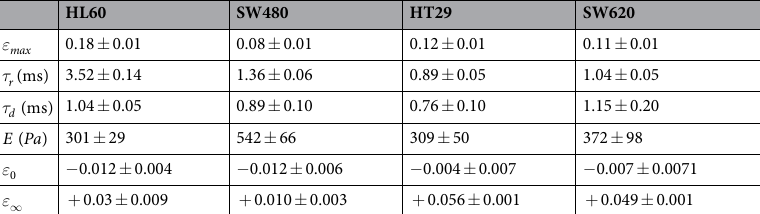
to those of SW620 at low flow rates, for μ < Q l min 30 / , but undergo less deformation with increasing flow rate and end up displaying properties close to those of the SW480 for higher flow rates, ≥ µ Q l min 40 / . Figure 2b shows DI/A as a function of Q , in a inertia-dominant regime where the suspension buffer viscosity was 1 cP. An abrupt change in behavior can be seen at μ = Q l min 400 / , which was identified as the yield stress of the cells and is associated to cytoskeletal breakdown 32 . For each cell line there is a linear relationship between DI/A and Q for μ < Q l min 300 / . For flow rates μ ≥ Q l min 400 / there is also a linear trend, however the gradient increases for both SW480 and SW620. For μ < Q l min 400 / , SW620 are the most deformable and SW480 are the least deformable. However, for μ ≥ Q l min 400 / the cell lines are less distinguishable from each other. Figure S1 shows the unnormalized data, DI as a function of Q, for the three cell lines in both shear and inertia-dominant regimes. Averaged deformation traces were measured for each of the 3 cell lines, supplementary videos 1–3 show exam- ple deformation events. Figure 3 shows the average strain ε as a function of time for SW480, HT29 and SW620 cells as they deform and recover in the extensional flow device. Cells were deformed in a shear-dominant and low velocity regime ( μ μ = . ± . = cP Q l 33 4 0 3 and 5 /min ). Multiple parameters were determined from the aver- aged deformation traces of N = 56 SW480, N = 49 HT29 and N = 50 SW620, which are labelled in the traces in Fig. 3 and values are summarised in Table 1. A is the initial cell diameter, ε in the maximum strain, ε is the max 0 is the deformation time as the cell deforms. After cells reached their initial strain before entering the SP and τ d near to the SP, the strain began to decrease exponentially as the cells traversed the outlet maximum strain ε max channel. A cell relaxation time, τ , was extracted from an exponential fit, as well as a final strain ε ∞ from extrapo- r lation of the fit. The strain values are vectors due to the inlet channels being perpendicular to the outlet channels, hence some ε values are slightly below 0 due to small deformations induced by shear channel confinement. Thus, 0 if cells recover their original shape after deformation the magnitude of initial strain should be the same as the magnitude of final strain ( ε ε | | = | | ∞ ). The areas shaded in pink in Fig. 3 are a width of ε | | 2 , and denote whether 0 0 cells recover their initial strain. The elastic modulus E was extracted using the Kelvin-Voigt model (Eq. 4). Figure S2 shows the velocity pro- files calculated along the central axis of the extensional flow junction, that were fitted with a sine function and